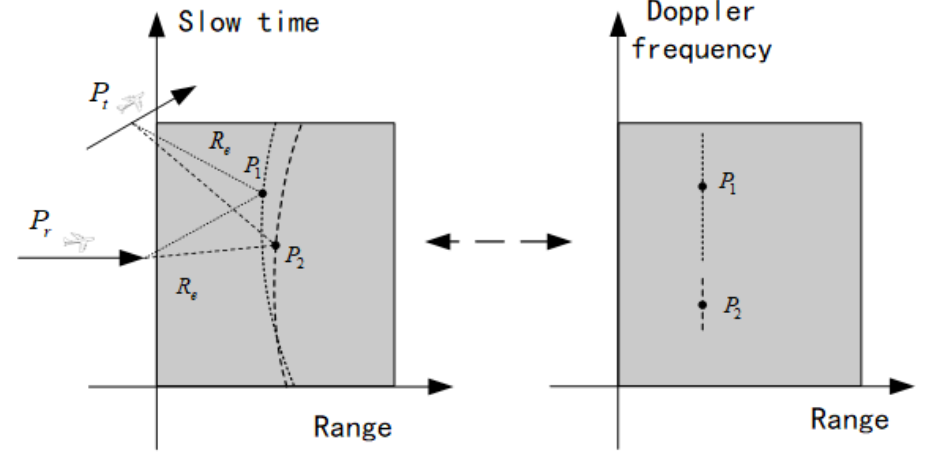
Figure 7. Variance model along the cross-range direction. P 1 and P 2 are with the same bistatic slant range and are separated in the Doppler domain.